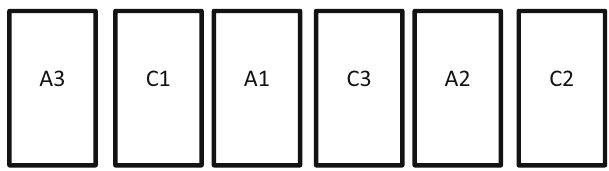
Figure 1: Experimental design and the placement of rearing units. Ax: aquaponic system with an x replicate unit, Cx: conventional aqua - culture system with an x replicate unit.